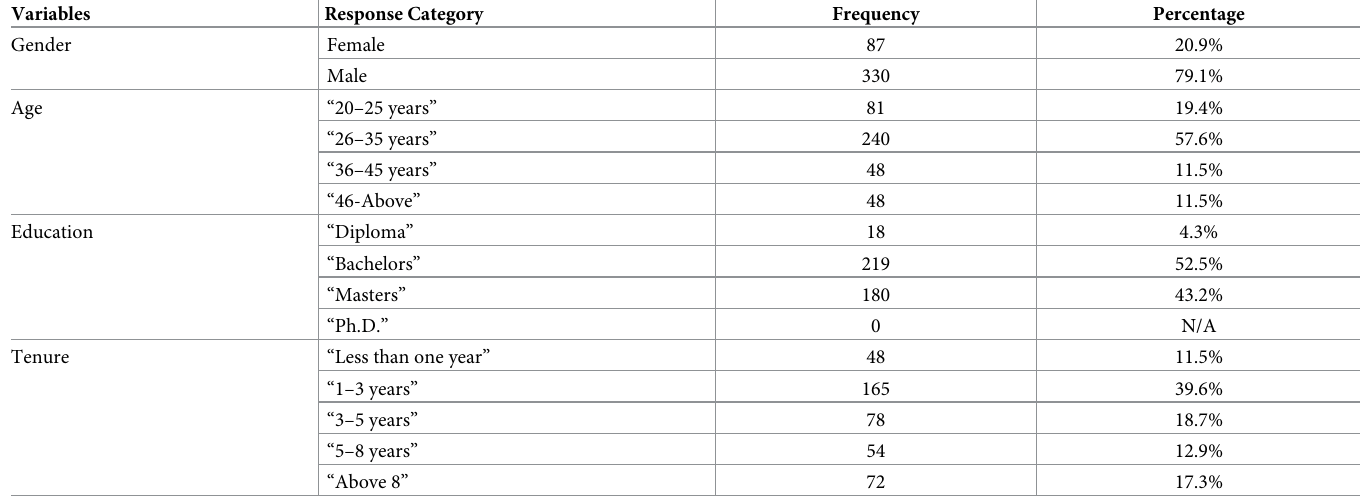
Table 1. Demographics composition of respondents or